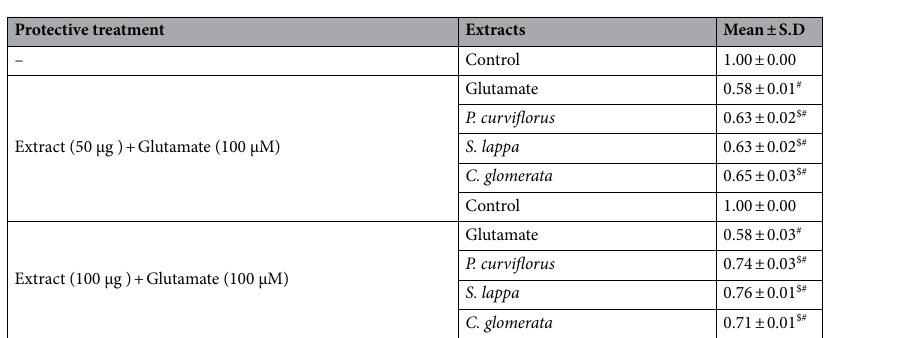
Figure 3. Percentage change of cell viability of RGCs treated with serial concentrations of P. curviflorus treated; S. lappa treated, and C. glomerate compared to control untreated-healthy cells ( A ) and glutamate-intoxicated cells ( B ).